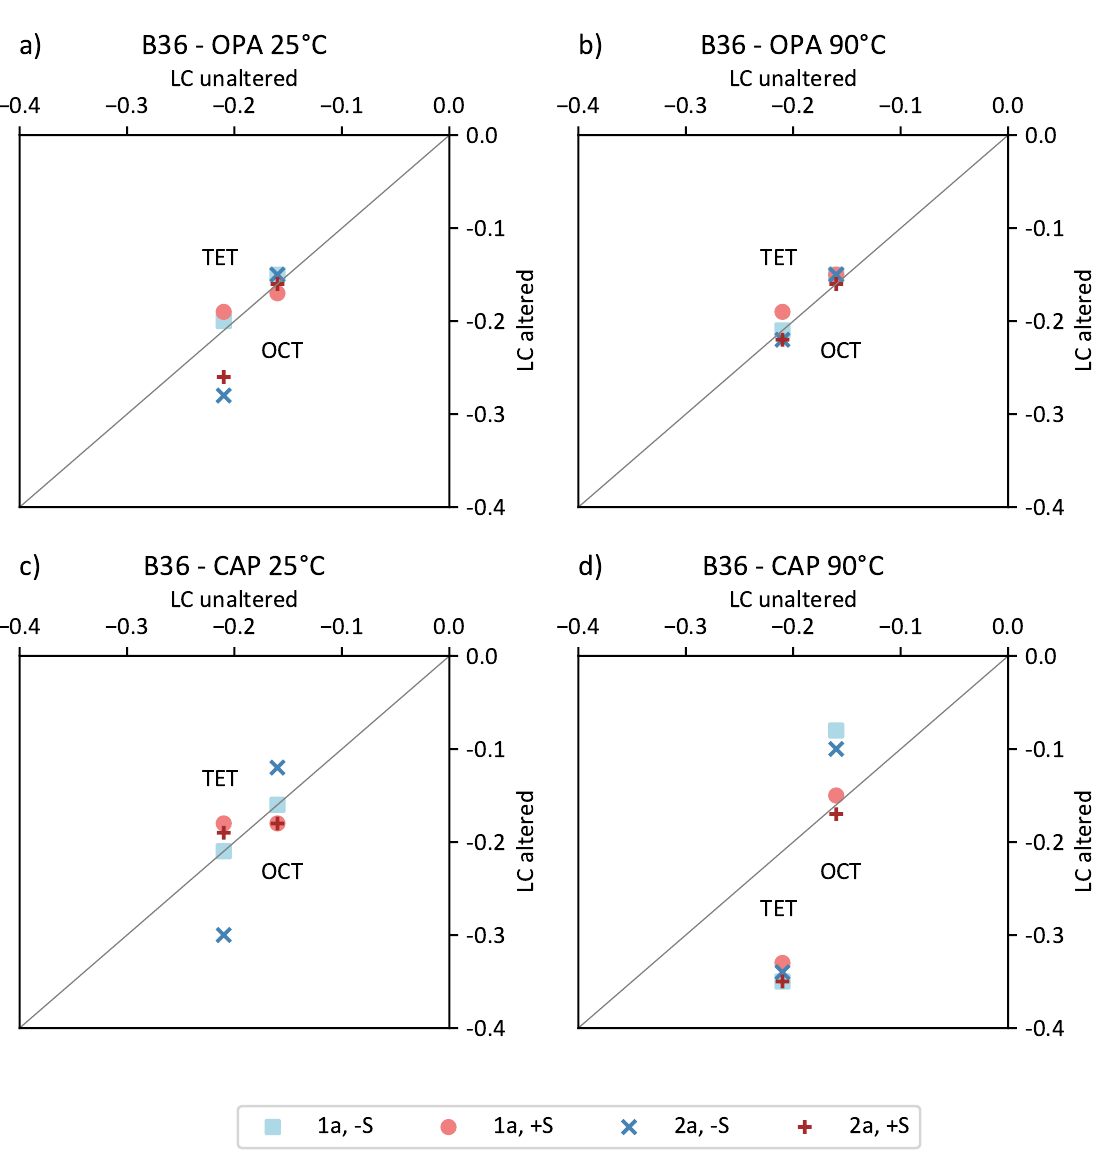
Figure 11. Scatter plots for B36 smectites that compare the altered tetrahedral (TET) and octahedral (OCT) charges to the initial charge distribution for samples reacted in ( a , b ) Opalinus clay pore water (OPA) and ( c , d ) diluted cap rock solution (CAP). An increase of the tetrahedral charge was observed for samples reacted in OPA solution at 25 ◦ C after two years ( a ) and in the corresponding control sample reacted in CAP solution ( c ). B36 samples reacted in CAP solution at 90 ◦ C show the highest changes, with an overall increase in tetrahedral charge along with a decrease in octahedral charge for the control samples. LC: layer charge, –S: control samples without substrate, +S: samples with